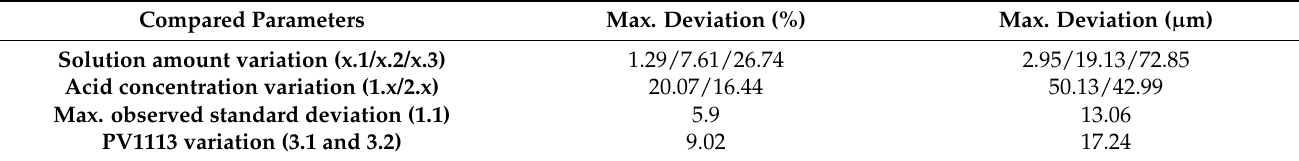
Table 5. Calculated deviations of the average corrosion depths. The numbers in brackets relate to the compared samples. Compared Parameters Max. Deviation (%) Max. Deviation ( µ m) Solution amount variation (x.1/x.2/x.3) Acid concentration variation (1.x/2.x) Max. observed standard deviation (1.1) PV1113 variation (3.1 and